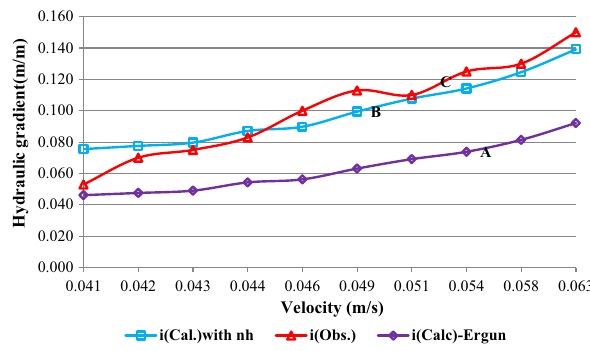
Fig. 12 Comparing plots of hydraulic gradient versus velocity for CGM2 series. Result is after 840 s of run start. Curve “A” shows vari- ations of ( i ) versus ( V ) based on common porosity concept, curve “B” shows variations of ( i ) versus ( V ) based on hydraulic porosity con- cept, curve “C” shows variations of ( i ) versus ( V ) based on actual model observations